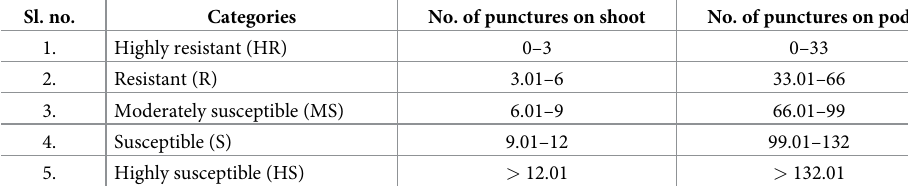
Table 2. Damage score rating on cocoa shoots and